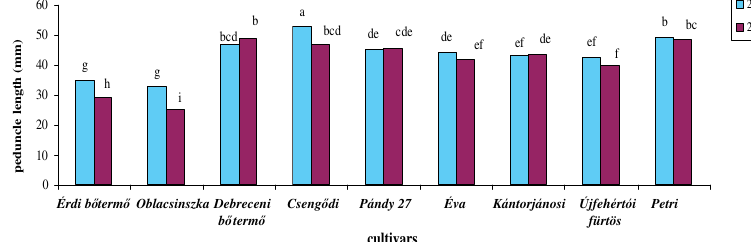
Figure 6. Peduncle length of the studied sour cherry cultivars in tow years (2008 & 2009). Different letters indicate significant differences between treatments (P